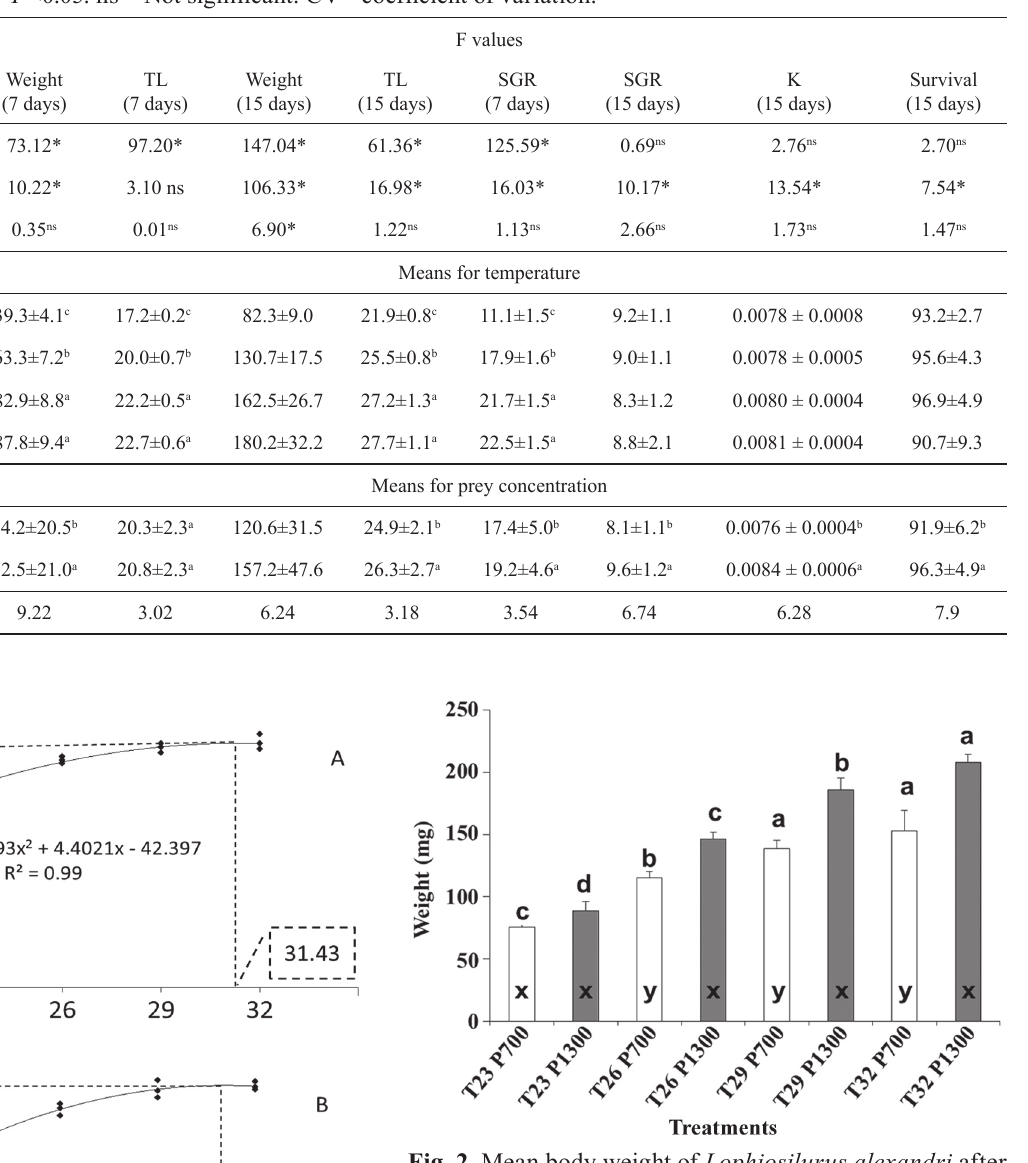
Fig. 2 . Mean body weight of Lophiosilurus alexandri after 15 days of exogenous feeding. Different letters represent significant differences ( P <0.05) among temperatures (a, b, c and d) and prey concentrations (x and y). The SGR during the first seven days of feeding was affected by temperature ( P <0.01) and prey concentrations ( P <0.01), but again without an interaction between temperature and prey ( P >0.05) (Table 2). Higher SGRs at were obtained with the prey concentrations of P 1,300 29 and 32 °C. Between the 8 th and 15 th day of exogenous feeding, SGR was modified only by the different prey concentrations ( P <0.01), and the P level provided the and P , 1,300 700 1,300 highest mean body